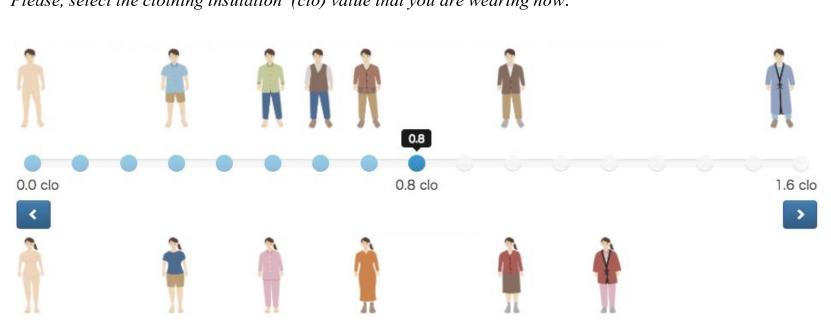
Figure 2. Questionnaire plate for clothing insulation value (actual questionnaire was provided in Japanese)